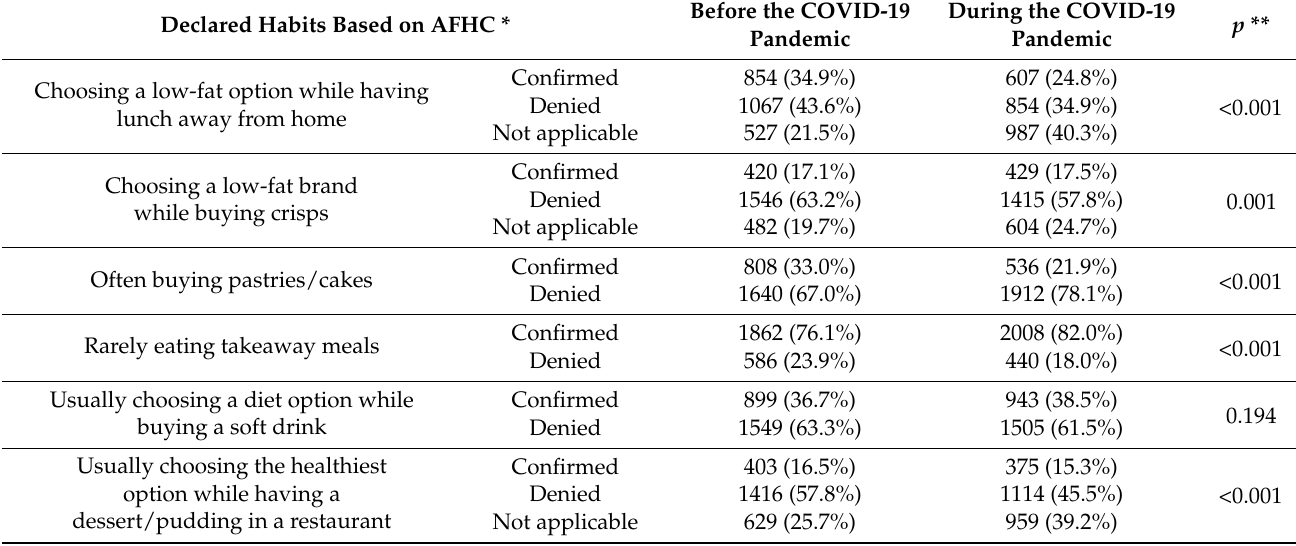
Table 2. The food purchase dietary habits assessed on the basis of the Adolescents’ Food Habits Checklist (AFHC) within the PLACE-19